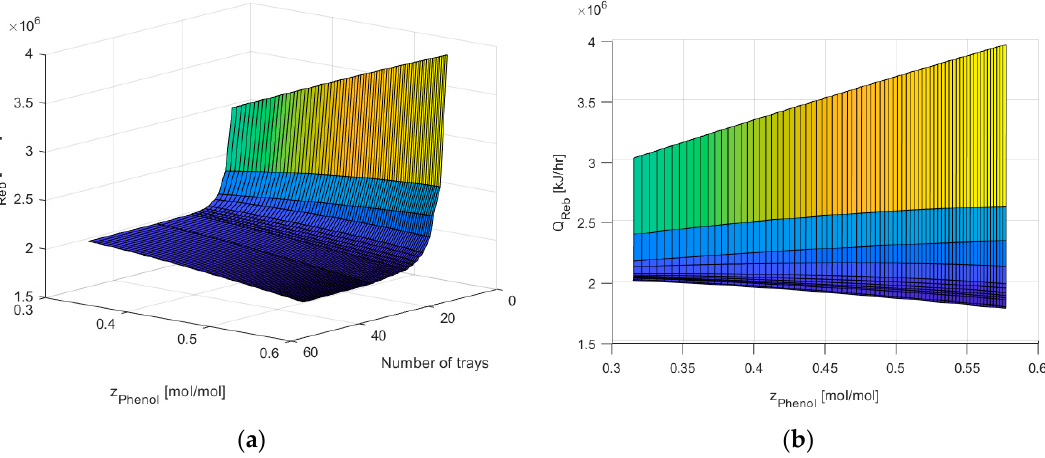
Figure 7. Reboiler duty under uncertain operating conditions: ( a ) side view; ( b ) front view. Different from the multiple effect evaporator case study, the heat duty trend with respect to the phenol molar fraction in the feed can be either increasing or decreasing in the considered interval according to the number of equilibrium stages.